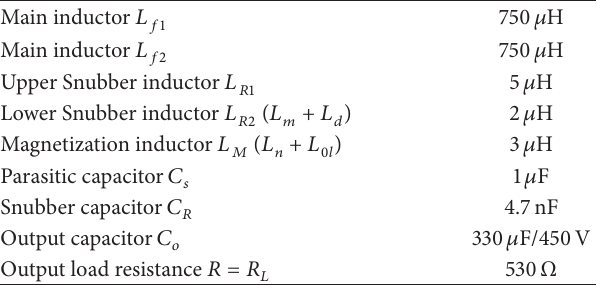
Table 2: Specification of parallel boost converter with active